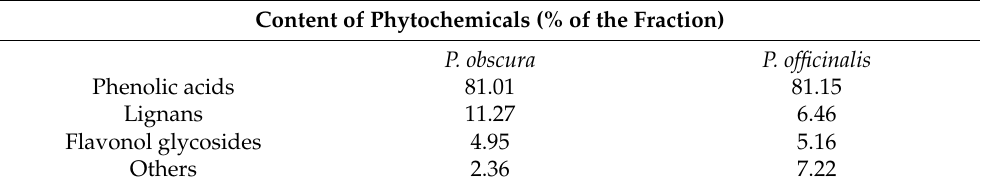
Figure 1. Chromatographic profile of Pulmonaria obscura and Pulmonaria officinalis phenolic-rich fractions (signal form charged aerosol detector, numbers indicate compounds that were characterized and quantitatively analyzed, IS–internal standard). Table 1. Phytochemical composition of the examined phenolic-rich fractions isolated from P. obscura and P. officinalis .